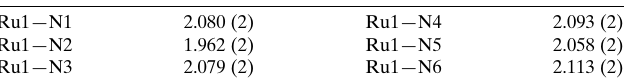
Table 2 Hydrogen-bond geometry (A˚ , (cid:5) ).